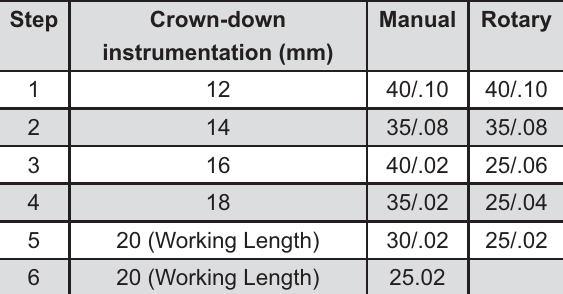
Figure 1- Instrumentation steps for manual and